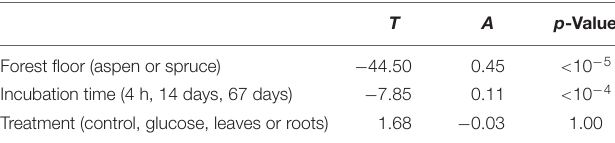
TABLE 3 | Multi-response permutation procedure (MRPP) results for PLFAs extracted from the aspen and spruce soil incubation units during the 67-day laboratory